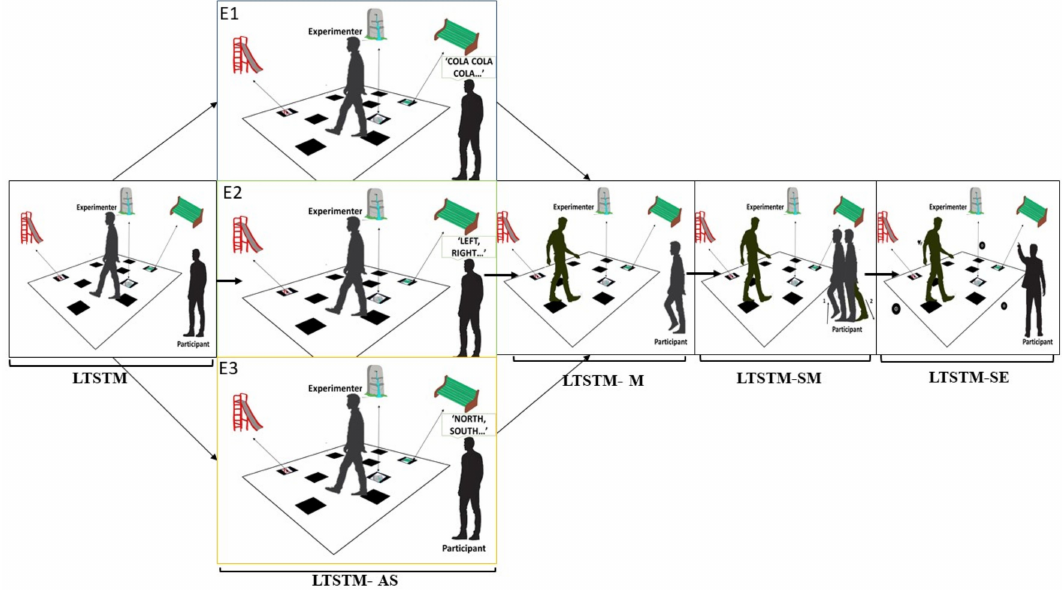
Figure 1. Experimental design and procedure. From left to right, figures show: the Walking Corsi Test (WalCT) administered to assess landmark topographical short-term memory (LTSTM), and the 4 dual-task interference conditions (articulatory suppression: LTSTM-AS; motor interference: LTSTM-M; spatial motor interference: LTSTM-SM and spatial environmental